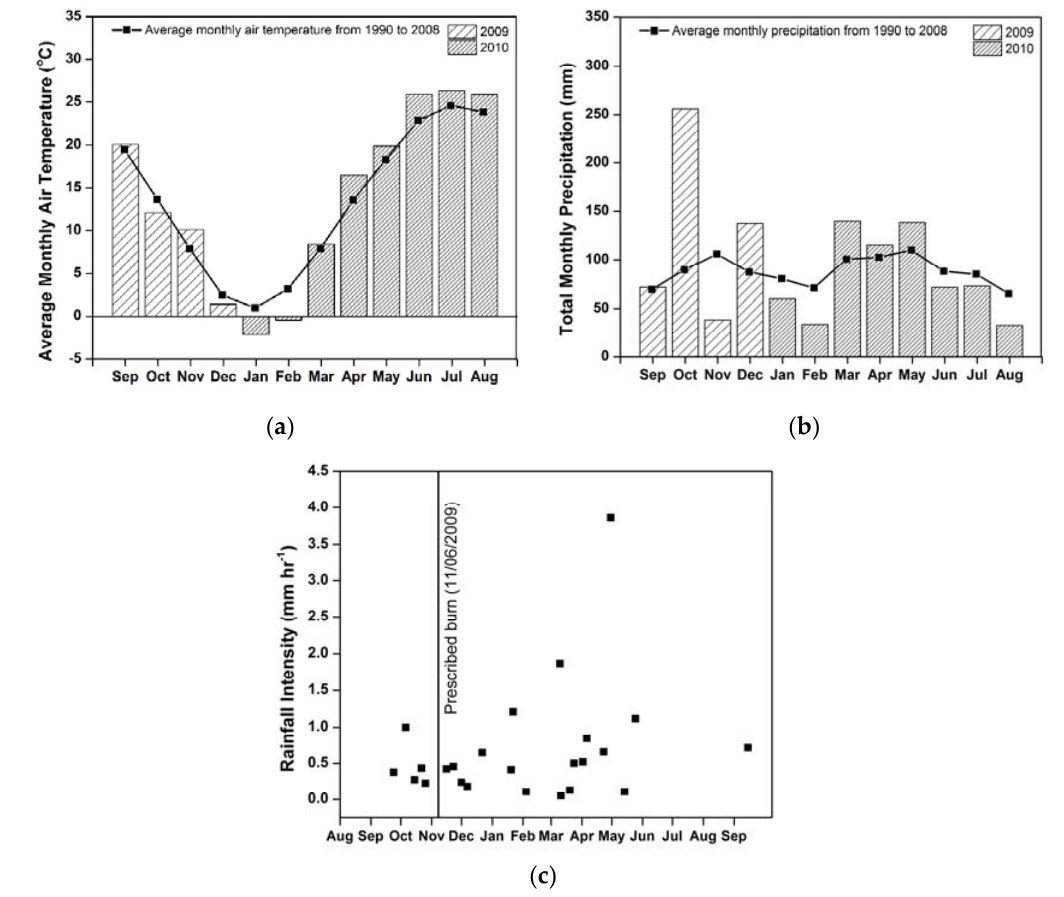
Figure 4. Average monthly air temperature ( a ); average monthly total precipitation ( b ); and rainfall intensity for runoff collection events ( c ) during 2009 and 2010 at Trail of Tears State Forest, IL.